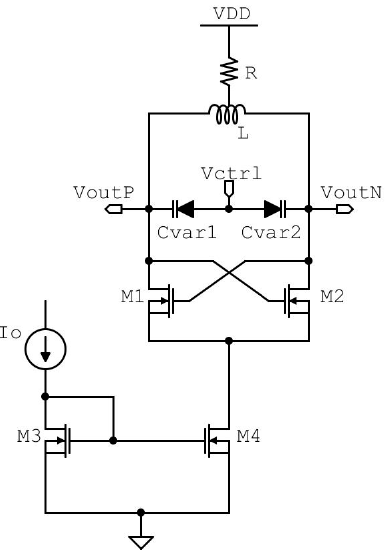
Figure 5. LC-tank VCO circuit schematic and a couple of varactors connected at the